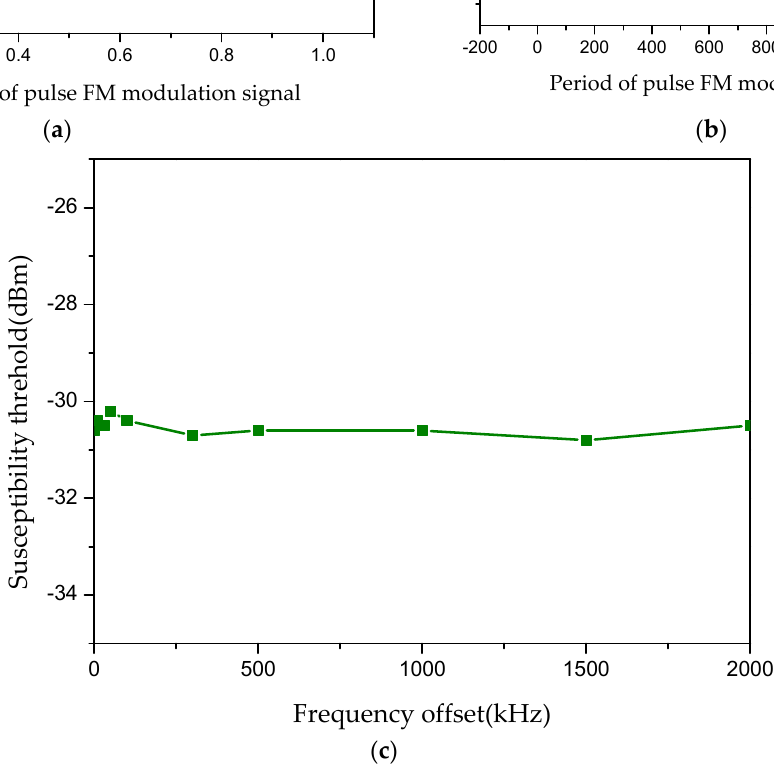
Figure 10. The susceptibility threshold curve of the laser sensing system under the interference of pulse frequency modulation signals: ( a ) under different duty cycles of pulse FM modulation signal; ( b ) under different period pulse FM modulation signals: ( c ) under different frequency offsets.